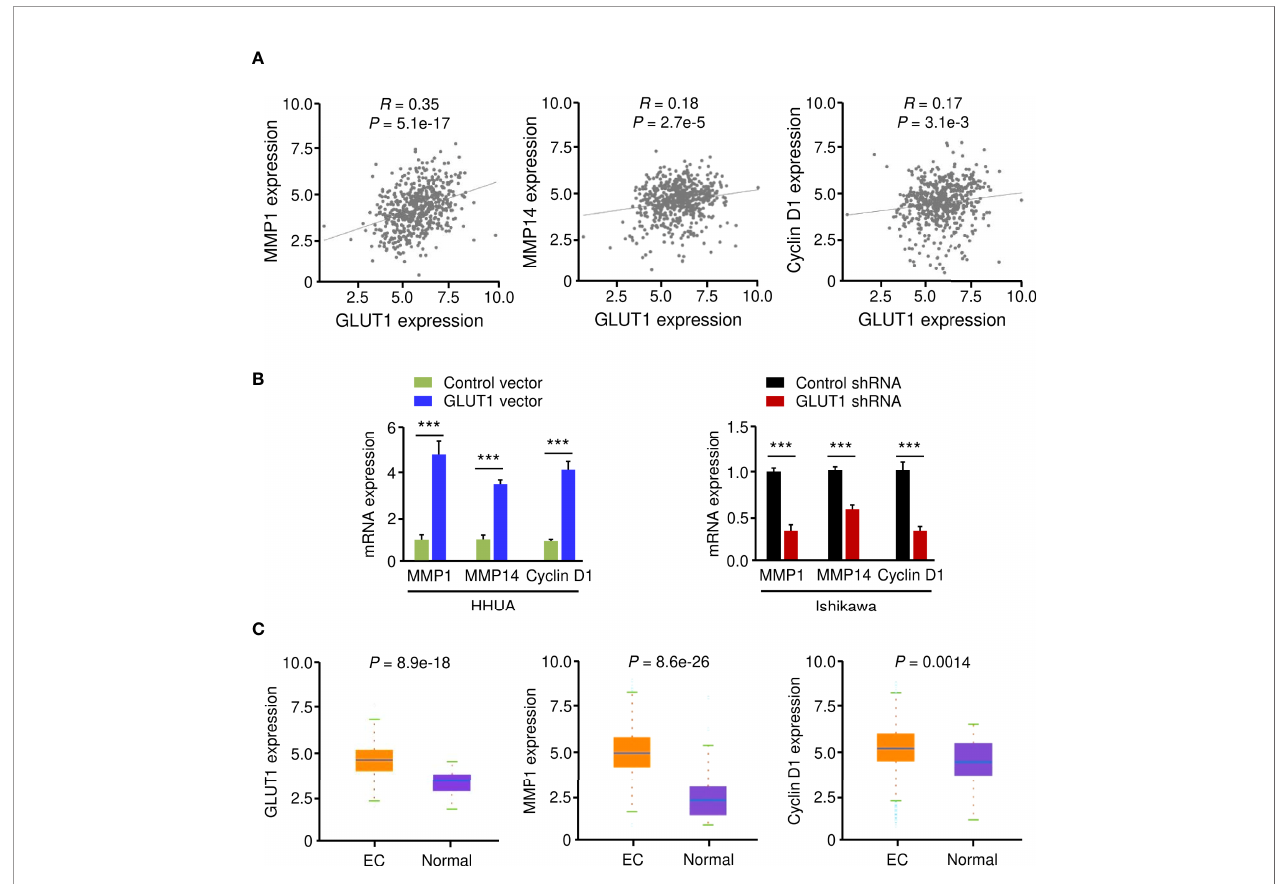
FIGURE 4 | GLUT1 is a Positive Upstream Regulator of MMP1, MMP14, and Cyclin D1. (A) The expression of GLUT1 was positively correlated with the expression of MMP1, MMP14 , and Cyclin D1 in EC tissues from the TCGA dataset. (B) qRT-PCR analysis of the indicated genes in EC cells after overexpression or knockdown of GLUT1. (C) The expression of MMP1, MMP14 , and Cyclin D1 in TCGA EC and normal tissues (ENCORI database). *** P <